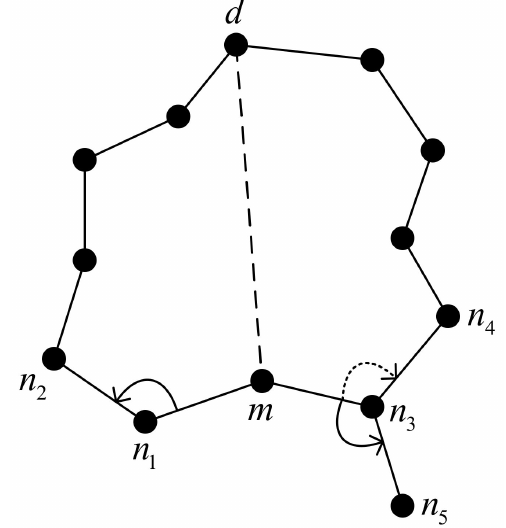
Figure 11. Wrong search